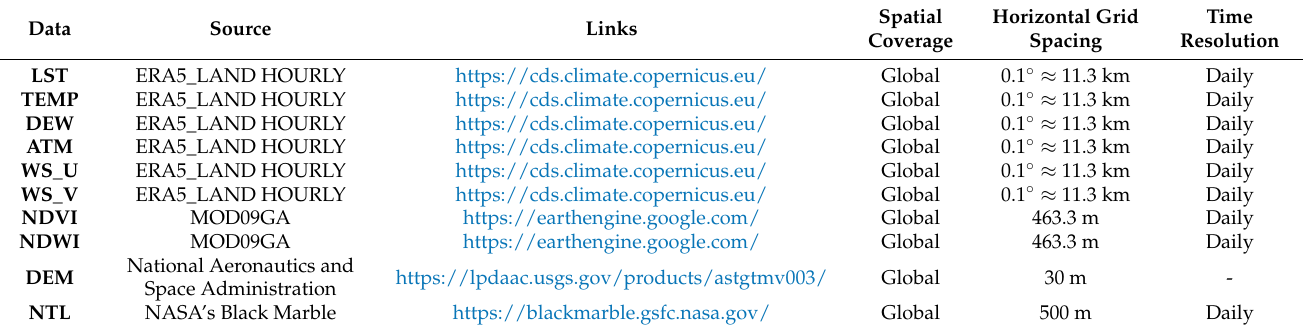
Table 1. Multi-source data used in the heat index calculation (links all accessed on 1 August 2022). Data